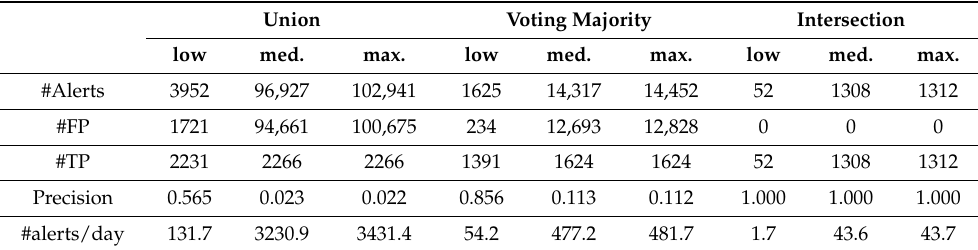
Table 6. Precision and alarm generation rate with a cooperative